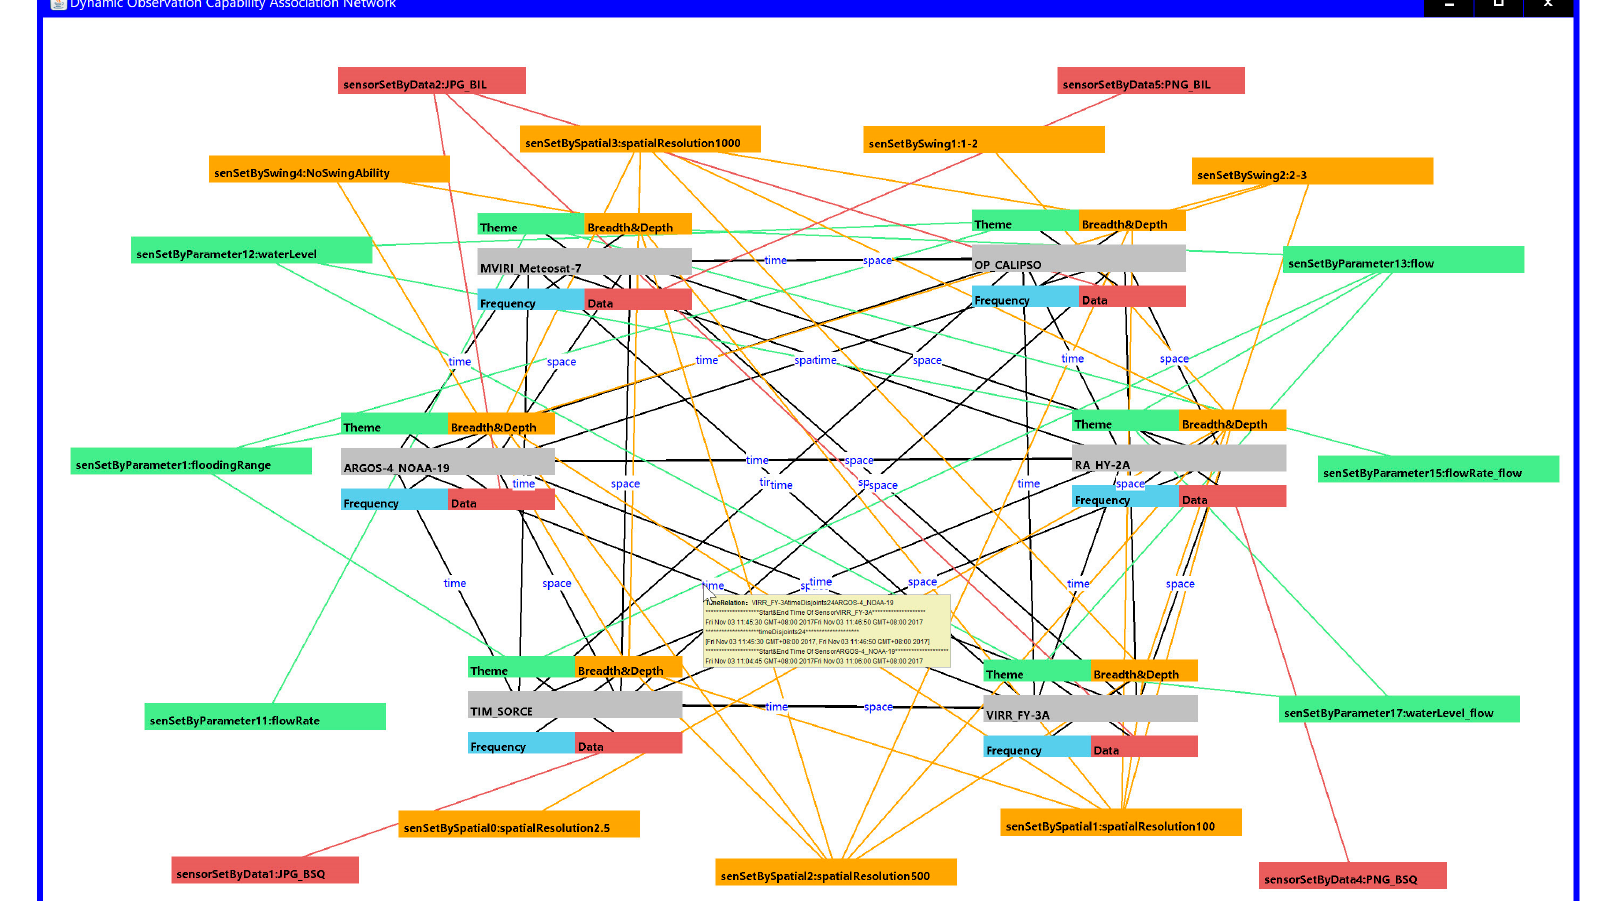
Figure 14. Example of the dynamic observation capability association network for the qualified satellite sensors.